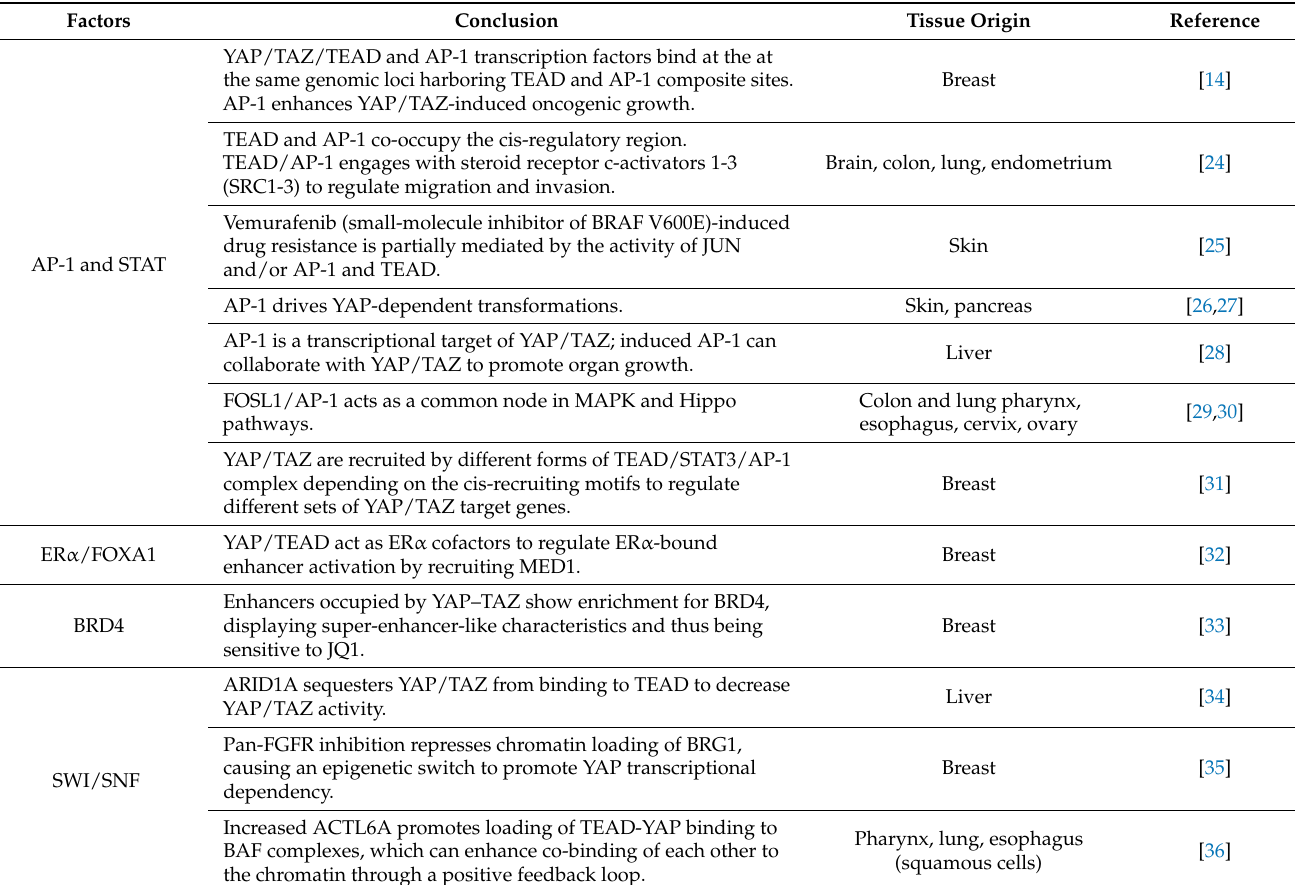
Table 1. Nuclear effectors of YAP/TAZ/TEAD that play a role in YAP-mediated transcriptional addictions and drug resistance in